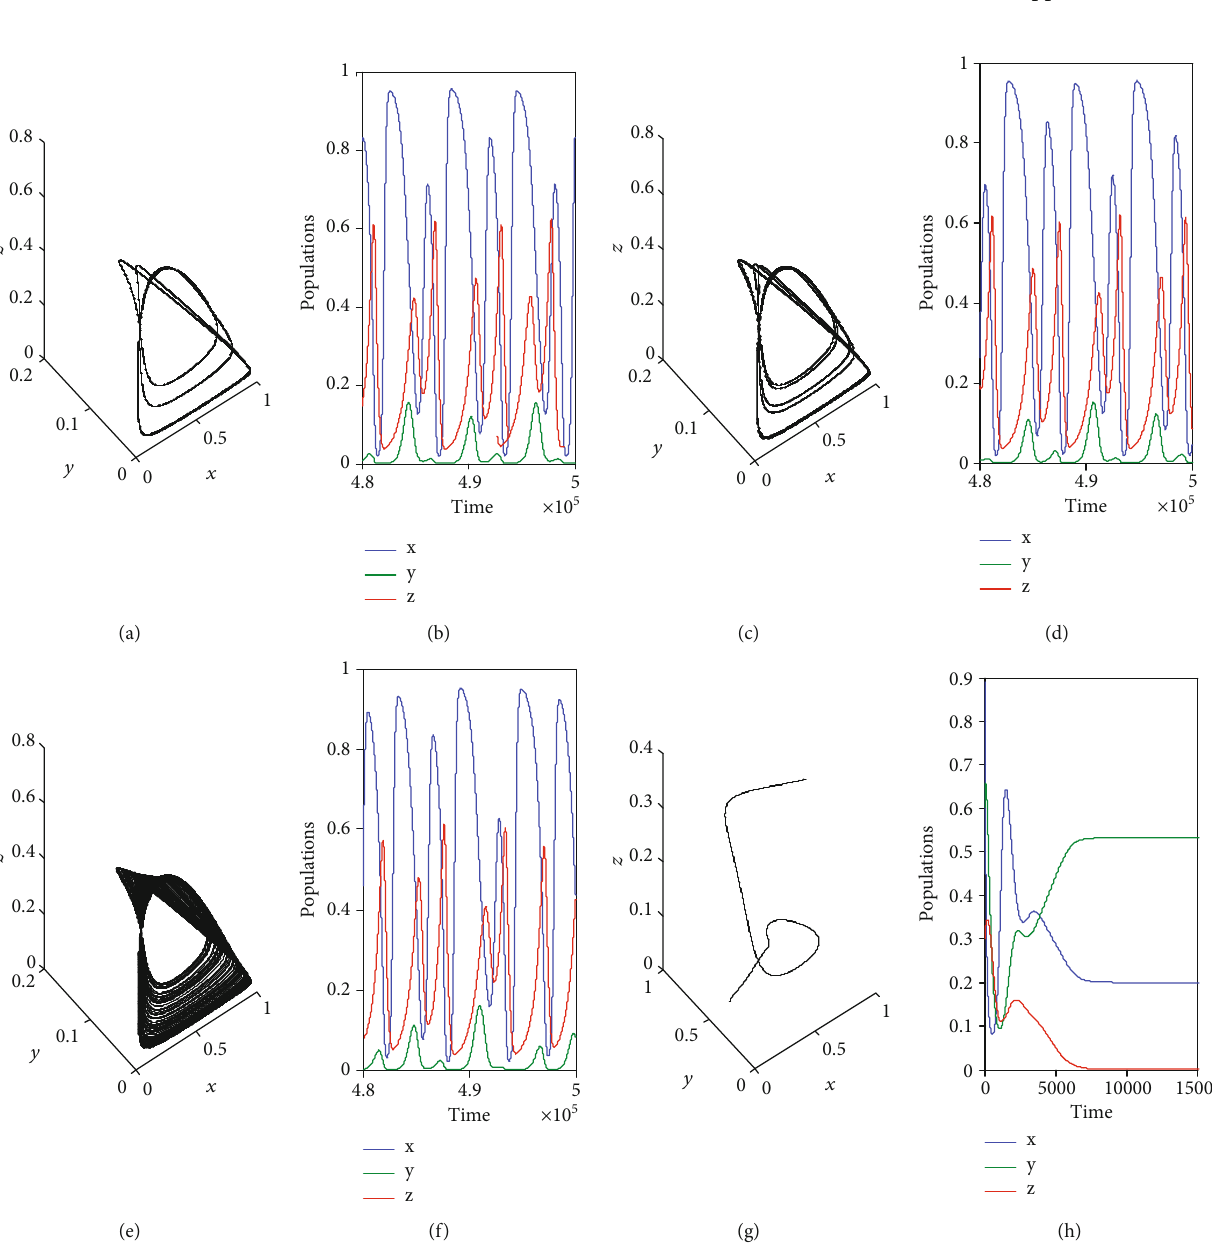
Figure 2: Trajectory of system (3) using the data given by Equation (87). (a) Period 3 in Int : ℝ 3 (a). (c) Period 5 in Int : ℝ 3 + where c = 0 : 47 . (d) Time series of attractor in (c). (e) Chaotic attractor in Int : ℝ 3 + where c = 0 : 55 . (f) Time series of attractor in (e). (g) Asymptotic stable PFEP in the xy -plane given by E 2 = ð 0 : 2, 0 : 53, 0 Þ where c = 0 : 6